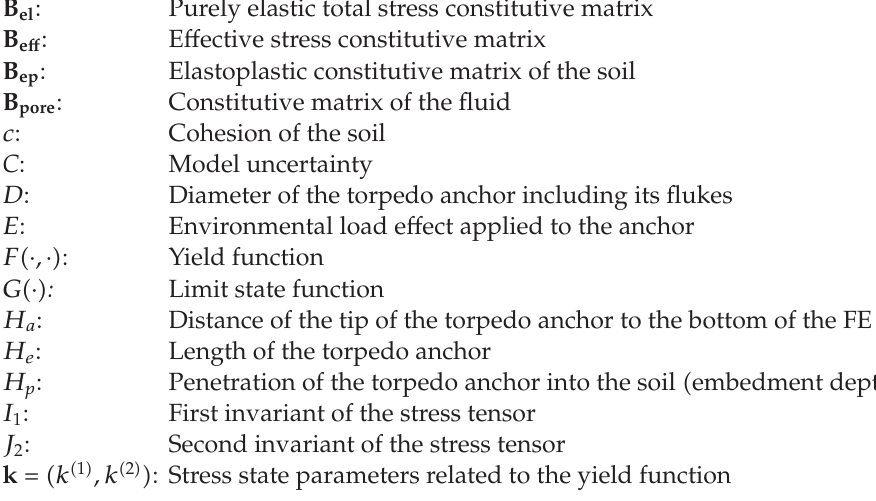
achieved with the use of lower safety factors. For instance, considering the WSD design methodology, the single safety factor has a significant reduction dropping from 2.0 to